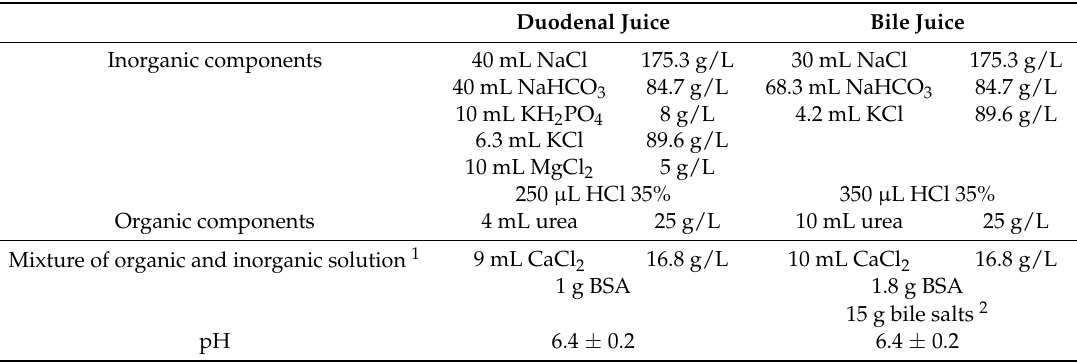
Table 1. Composition of duodenal and bile juices in the simulated small intestinal fluid. Duodenal Juice Bile Juice Inorganic components 40 mL